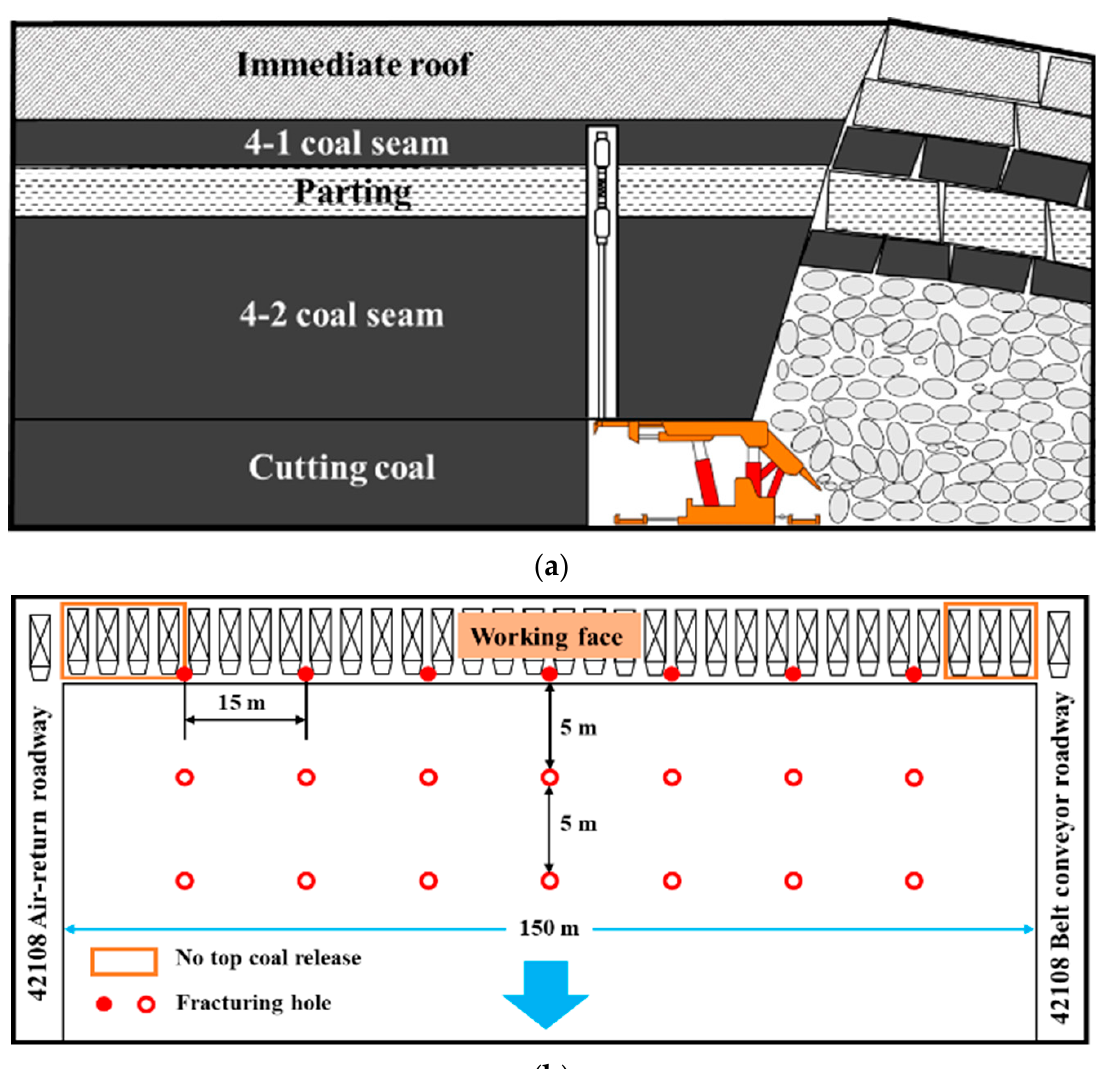
Figure 14. Plane section layout of fracturing holes between hydraulic-powered supports in working face. ( a ) Fracturing hole profile layout in working face. ( b ) Plane layout of fracturing holes in working face.